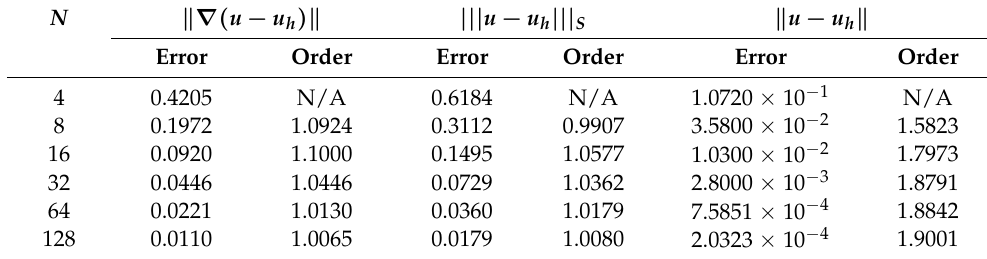
Table 8. Experiment results for the exact solution u = x 2 e y with B.C. II. N